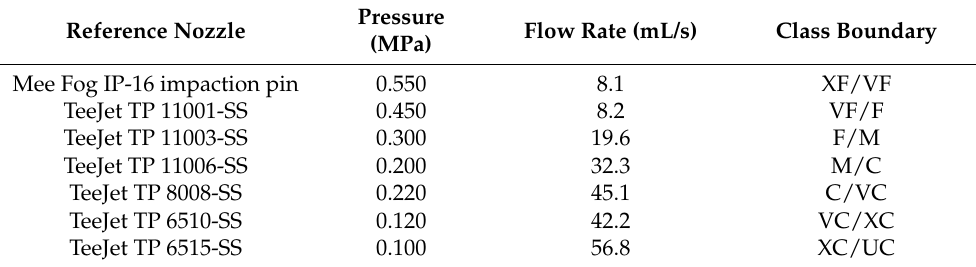
Table 1. Reference nozzles and pressure combination for class boundary definition (adapted from ISO 25358:2018